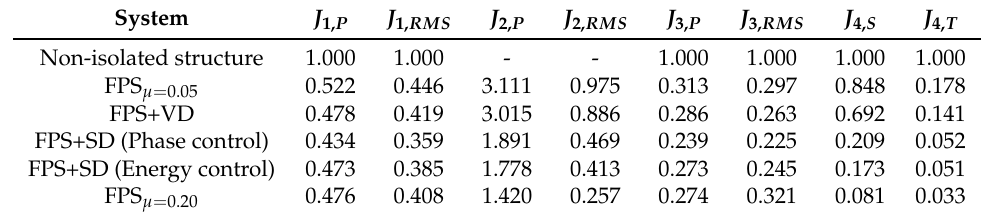
Table 3. Performance indexes (PIs) for the optimum configurations under the design earthquake.